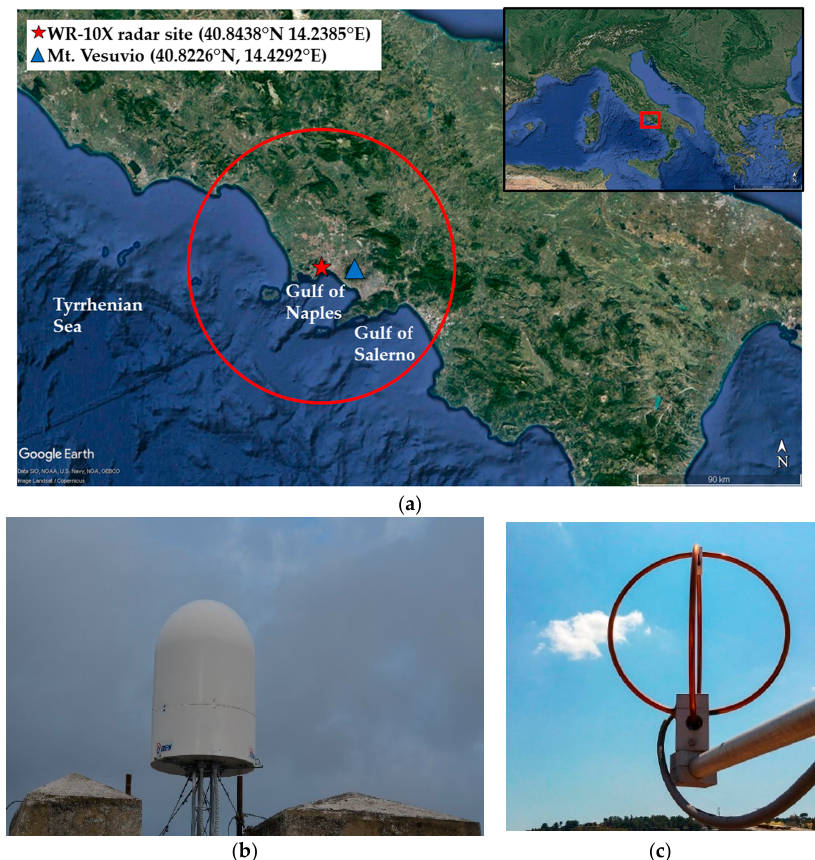
Figure 1. In ( a ), a map of study region, including WR-10X radar (filled-in red star) and Mount Vesuvio (blue triangle) locations, is presented. The red circular line at 72 km from Naples Castel Sant’Elmo indicates the limit of the area covered by the radar. In ( b ), WR-10X installation at Naples Castel Sant’Elmo Site is shown. In ( c ), a picture of LIghtning NETwork (LINET) stroke detection sensor, retrieved from [49], is presented.